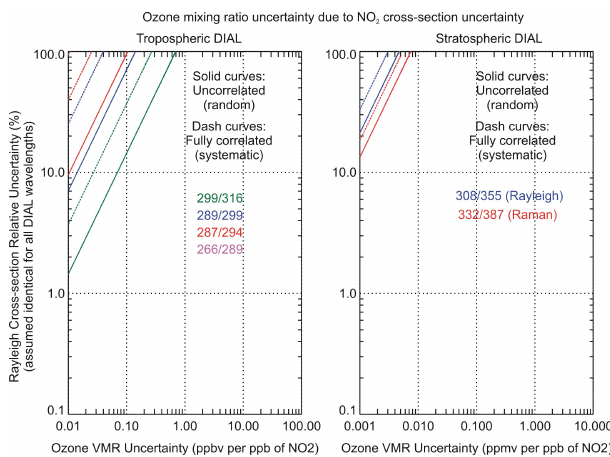
Figure 9. Ozone mixing ratio uncertainty as a function of NO 2 cross section relative uncertainty (%), assuming that all cross sections used have the same relative uncertainty. Solid curves are used for cases of independent (random) cross section datasets, and dashed curves are used for the case of full correlation between all cross sections.